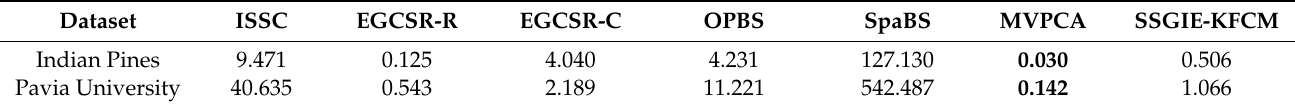
Table 5. Calculational time (in seconds) of different